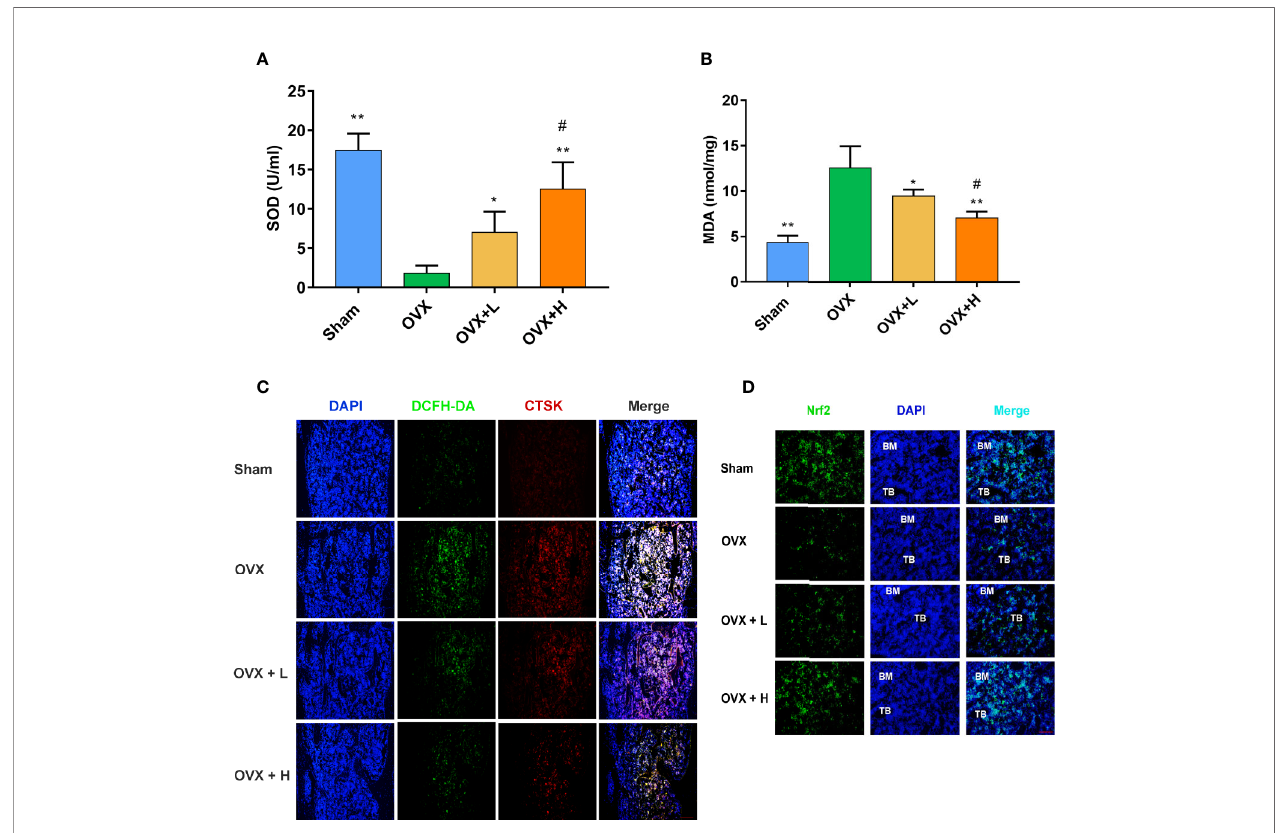
FIGURE 6 | TF3 remitted oxidative stress and increased the expression of Nrf2 in vivo . (A) Serum SOD level in mice. (B) Serum MDA level in mice. (C) DCFH-DA staining and immuno fl uorescence staining of CTSK showed the intracellular ROS level in femur. (D) The immuno fl uorescence staining displayed the expression of Nrf2 in femur. n = 6. * P < 0.05, ** P < 0.01 compared with OVX group. # P < 0.05 compared with OVX + L group. Scale bar = 100 m